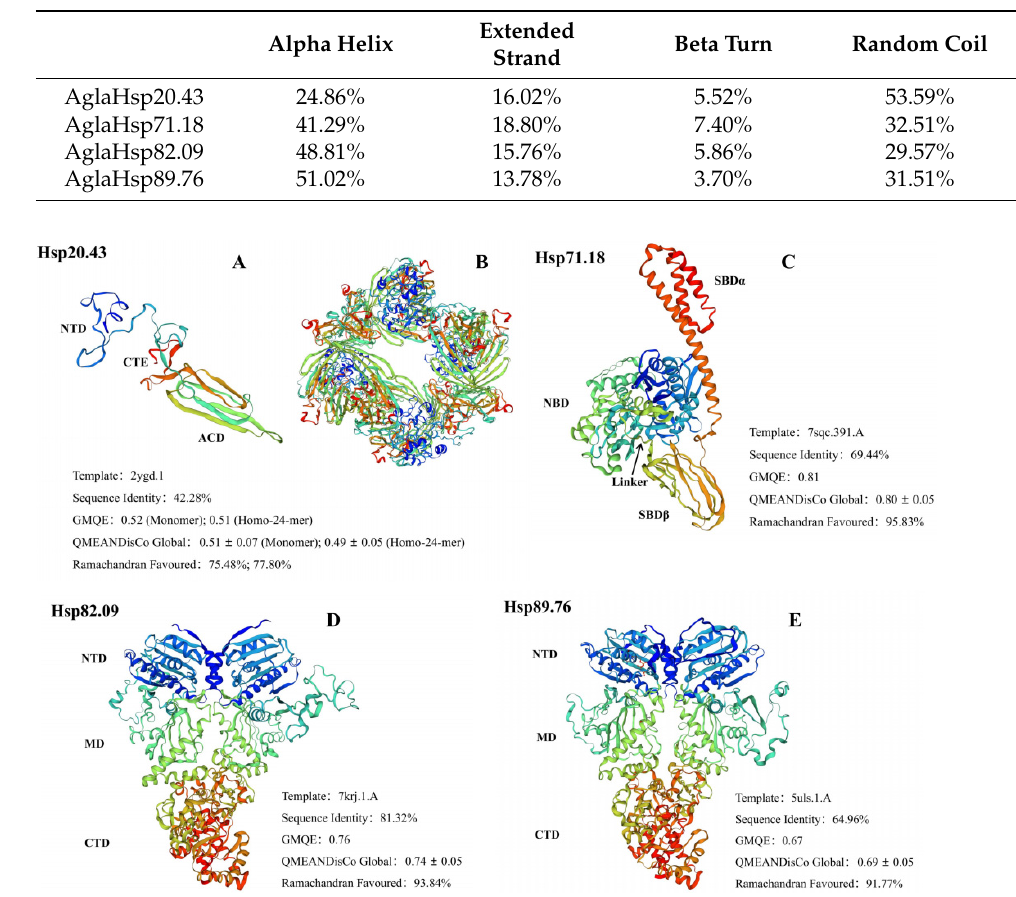
Figure 1. Three ‐ dimensional structures of AglaHsps proteins. Homo sapiens α‐ Crystallin